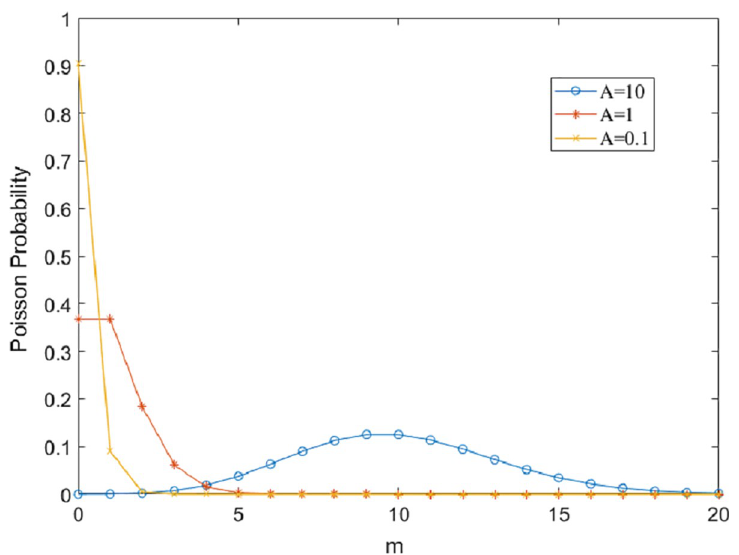
Fig 2. Poisson probability vs. the term number m with different mean